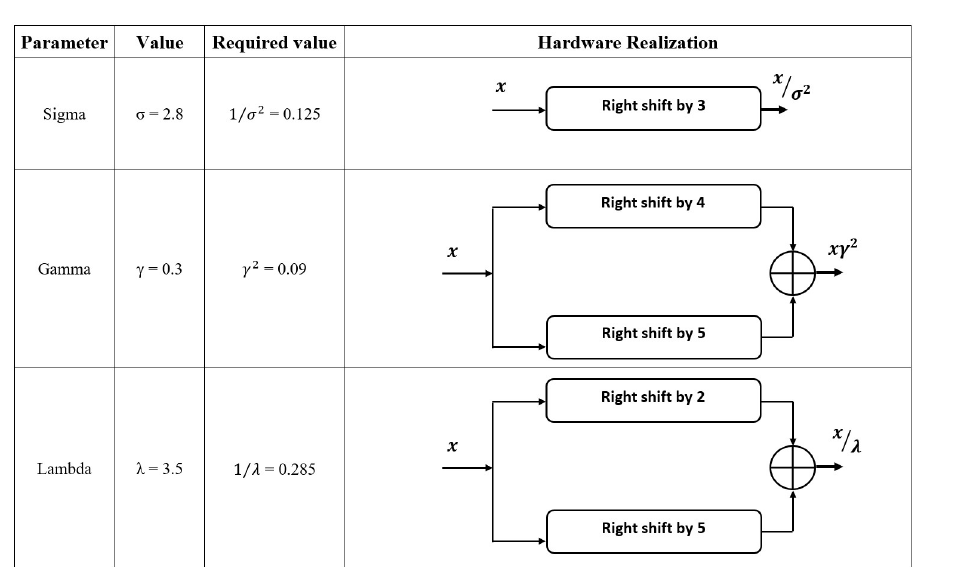
Figure 5. Proposed architecture of the Gabor filter model.